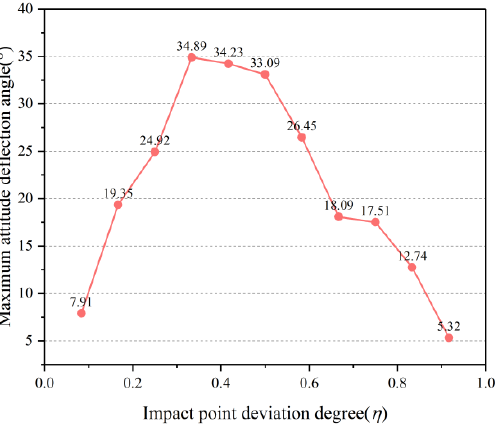
β β and impact and impact